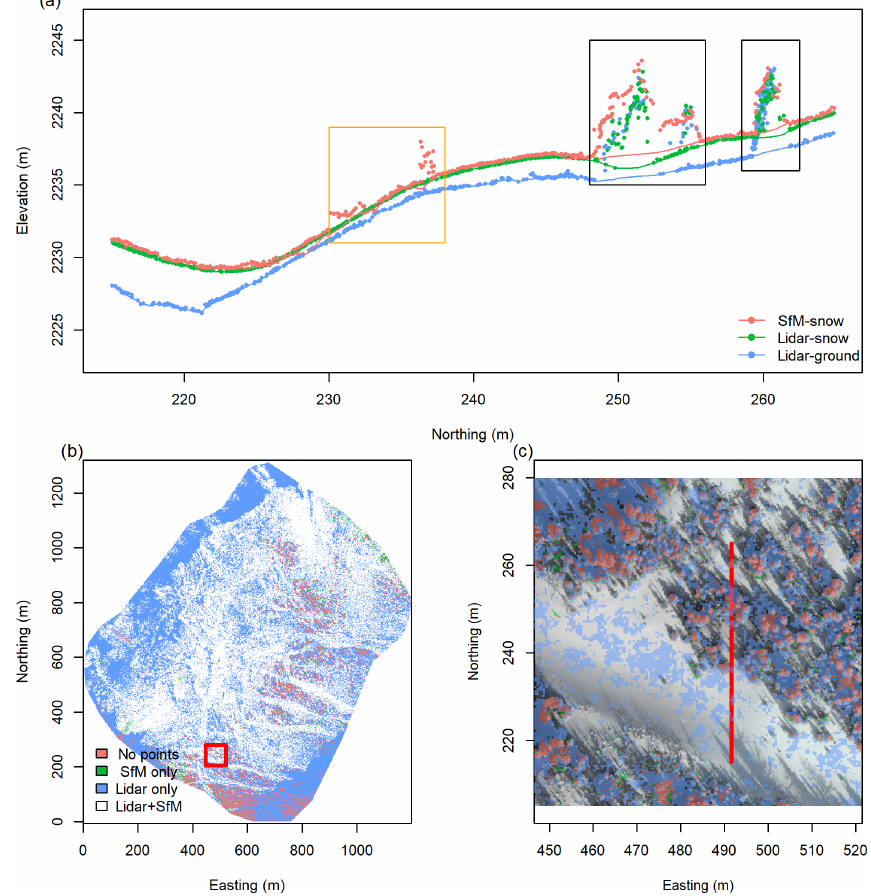
Figure 7. Fortress Ridge (14 February 2019) study site with an example (a) cross section with all points and the interpolated vegetation-free surface (lines) for SfM-snow (red), lidar-snow (green), and lidar-ground (blue) surveys. The study area is classified by areas with greater than 1pt per 0.25m − 2 in (b) with respect to point clouds obtained from UAV-lidar and UAV-SfM techniques. In (a) black polygons highlight areas of tree wells while the orange polygon highlights an area of UAV-SfM noise on a slope. The red inset polygon in (b) identifies the area of the orthomosaics displayed in (c) with the same overlain transparent point type classification colour scheme as shown in (b) . The red line in (c) corresponds to the cross section plotted in (a)